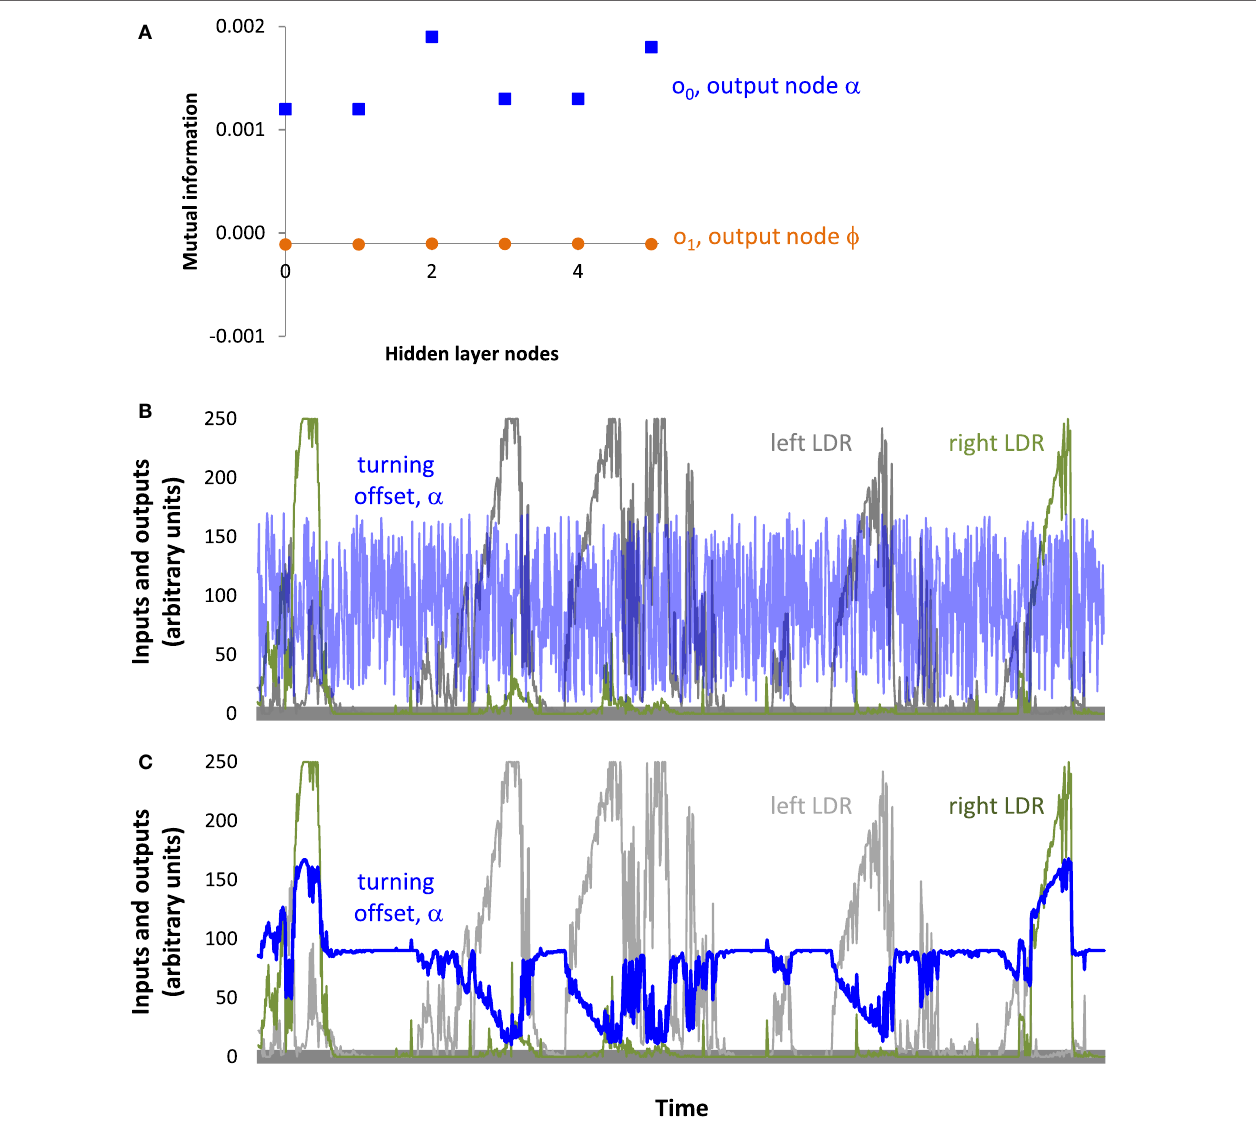
FigUre 11 | information pass-through for the ann of T_9_9 . (a) Mutual information is greater in the output node, α , connected to the ANN. Since the output node for ϕ is disconnected, it serves as a reference. Note that only hidden nodes 0, 3, 4, and 5 connect directly to output node 0; the passing of information from hidden nodes 1 and 2 occurs through the other hidden nodes, to which they are connected. (B) Oscillatory output. Inputs to the two light-dependent resistors (LDRs) and the resulting output to the turning offset of the tail, α . Inputs and outputs are the actual values logged by T_9_9 during a trial. (c) Without recurrence in the hidden layer, the signals at the sensors would produce a slowly changing turning signal that would steer Tadro left and right, depending on which LDR was stimulated. These are the same inputs as above but the output is